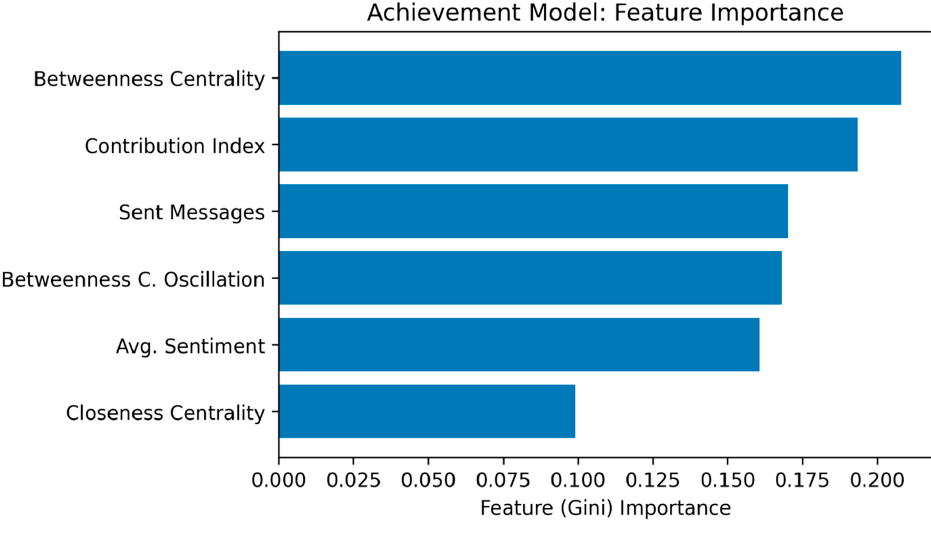
Figure 6. Feature Importance of Achievement Model.